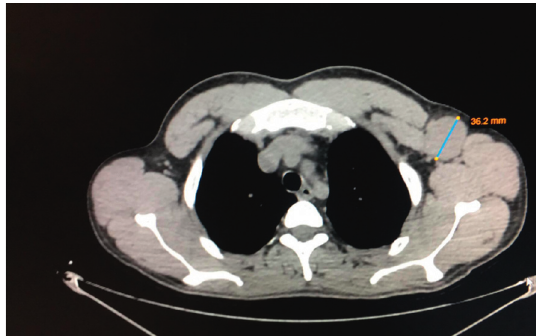
Figure 2: CT scan postoperatively showing a soft tissue lesion measuring 36.2 mm in the left axilla consistent of lymph node